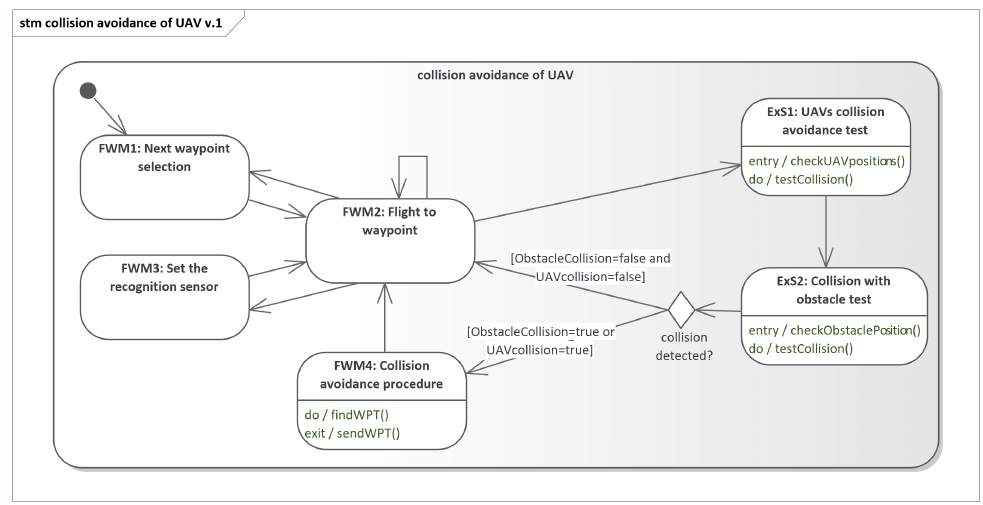
Figure 2. State machine diagram for a collision avoidance of UAV. Model for one core unit processor. Actions within the states are